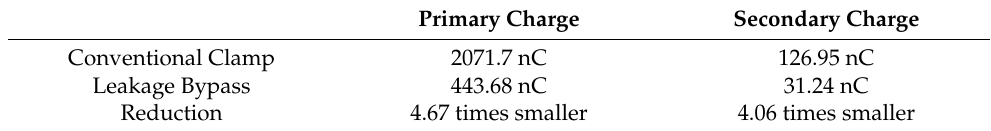
Table 4. Experimental result for charge circulation.